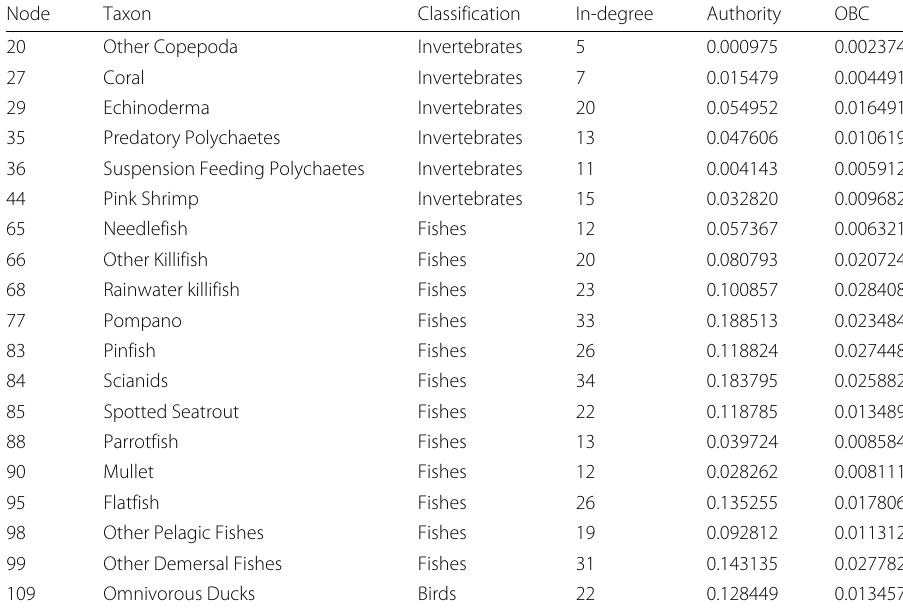
Table 3 Nodes with significantly high OBC in the Florida Bay food web. The values of in-degree and Authority score are also shown